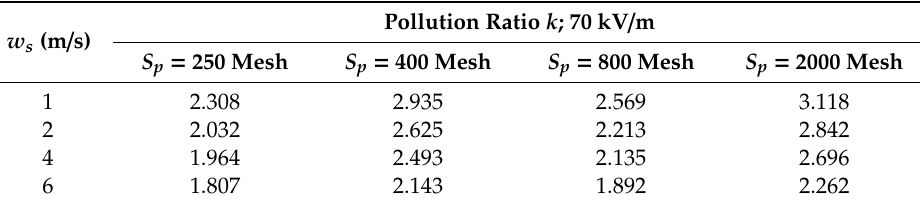
Table 6. Pollution ratio k under electrical stress of 70 kV / m.